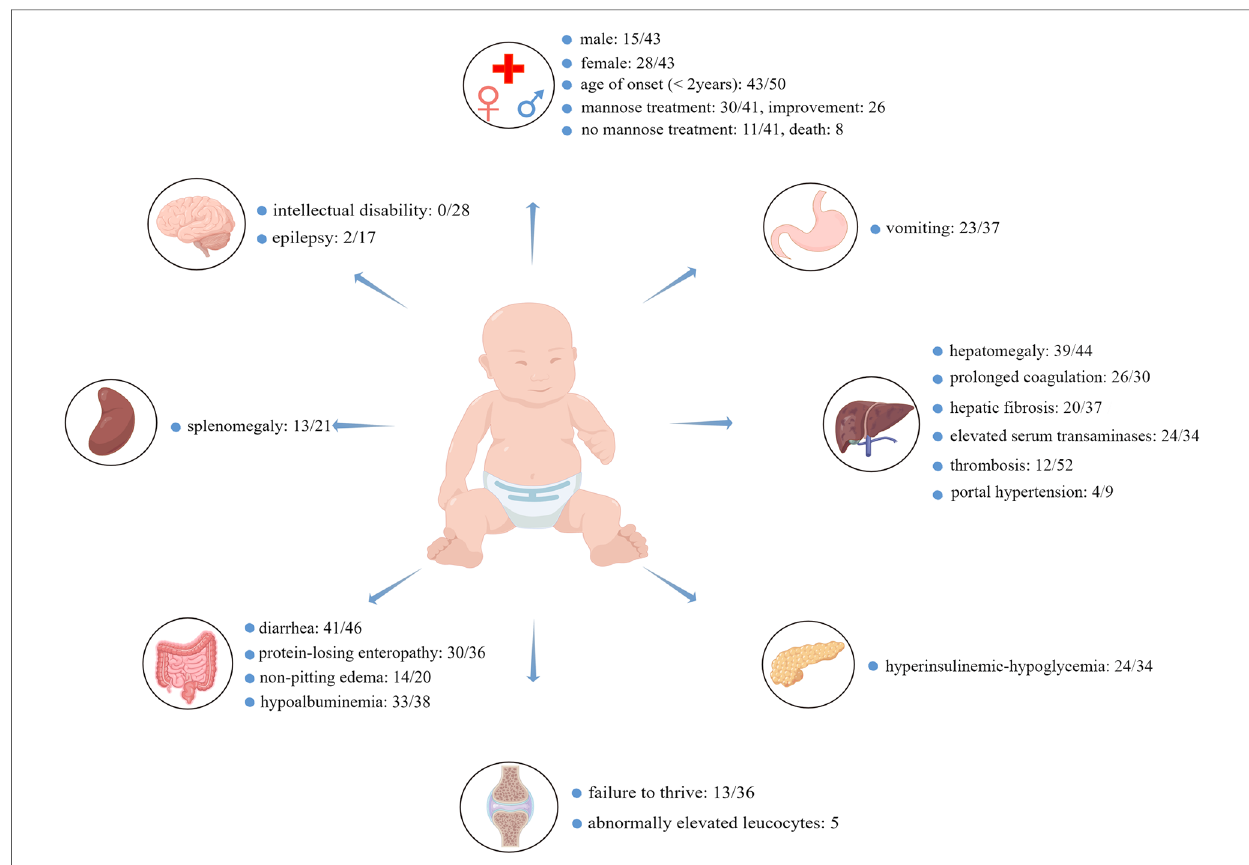
FIGURE 1 The most common clinical symptoms and abnormal laboratory fi ndings in MPI-CDG. In total, 52 cases were identi fi ed, and the age of onset of MPI-CDG was usually under 2 years of age. MPI-CDG typically presents with single or multi-organ involvement, commonly involving digestive and endocrine systems, but not the nervous system. Since not every article provided basic information about the MPI-CDG patients, clinical symptoms, or routine laboratory tests, the number of cases varied between studies, and uninformative cases were not counted in the total. For example, diarrhea: 41/46 means that 41 patients had diarrhea, fi ve patients did not, and relevant information was not provided for six